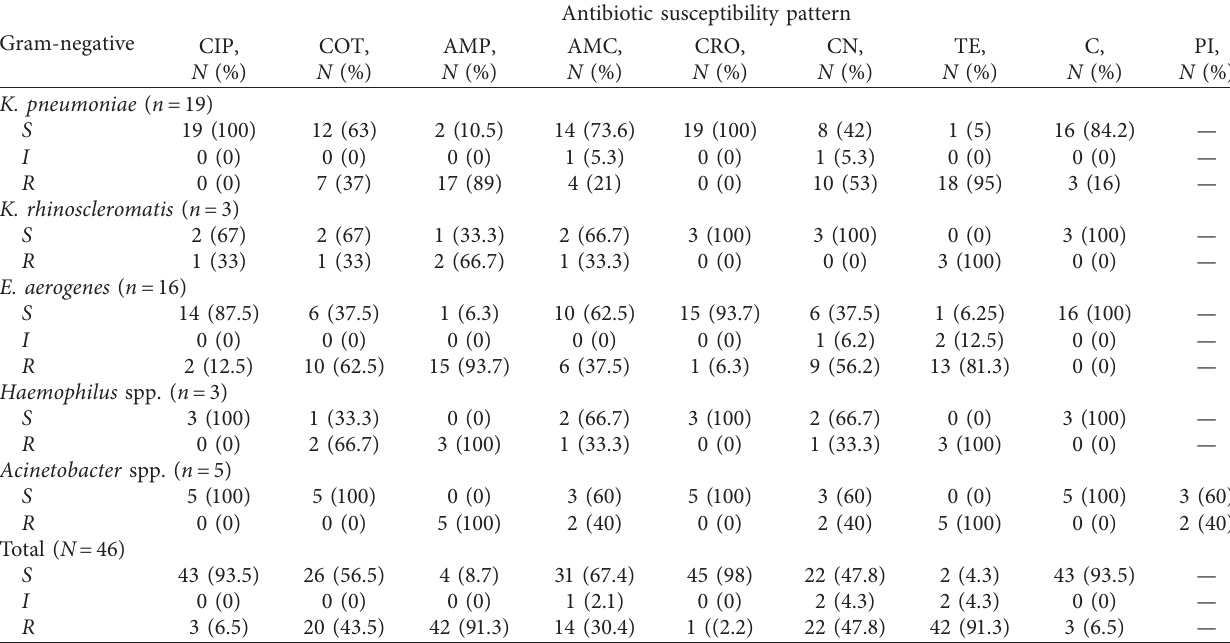
Table 4: Antibiotic resistance pattern of Gram-negative bacterial isolates among HIV/AIDS patients at Felege Hiwot Referral Hospital.